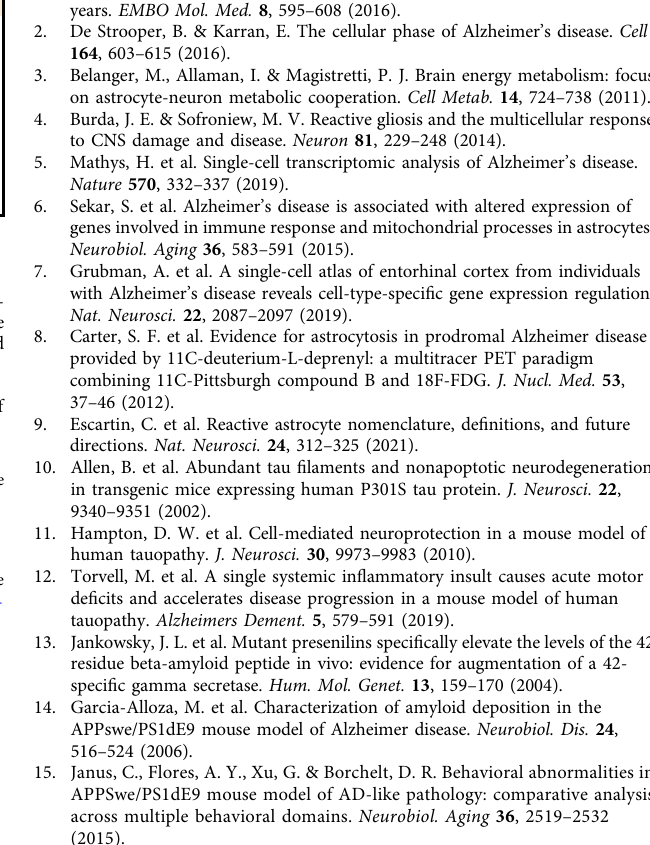
Table 3 Scoring system for horizontal bar testing.